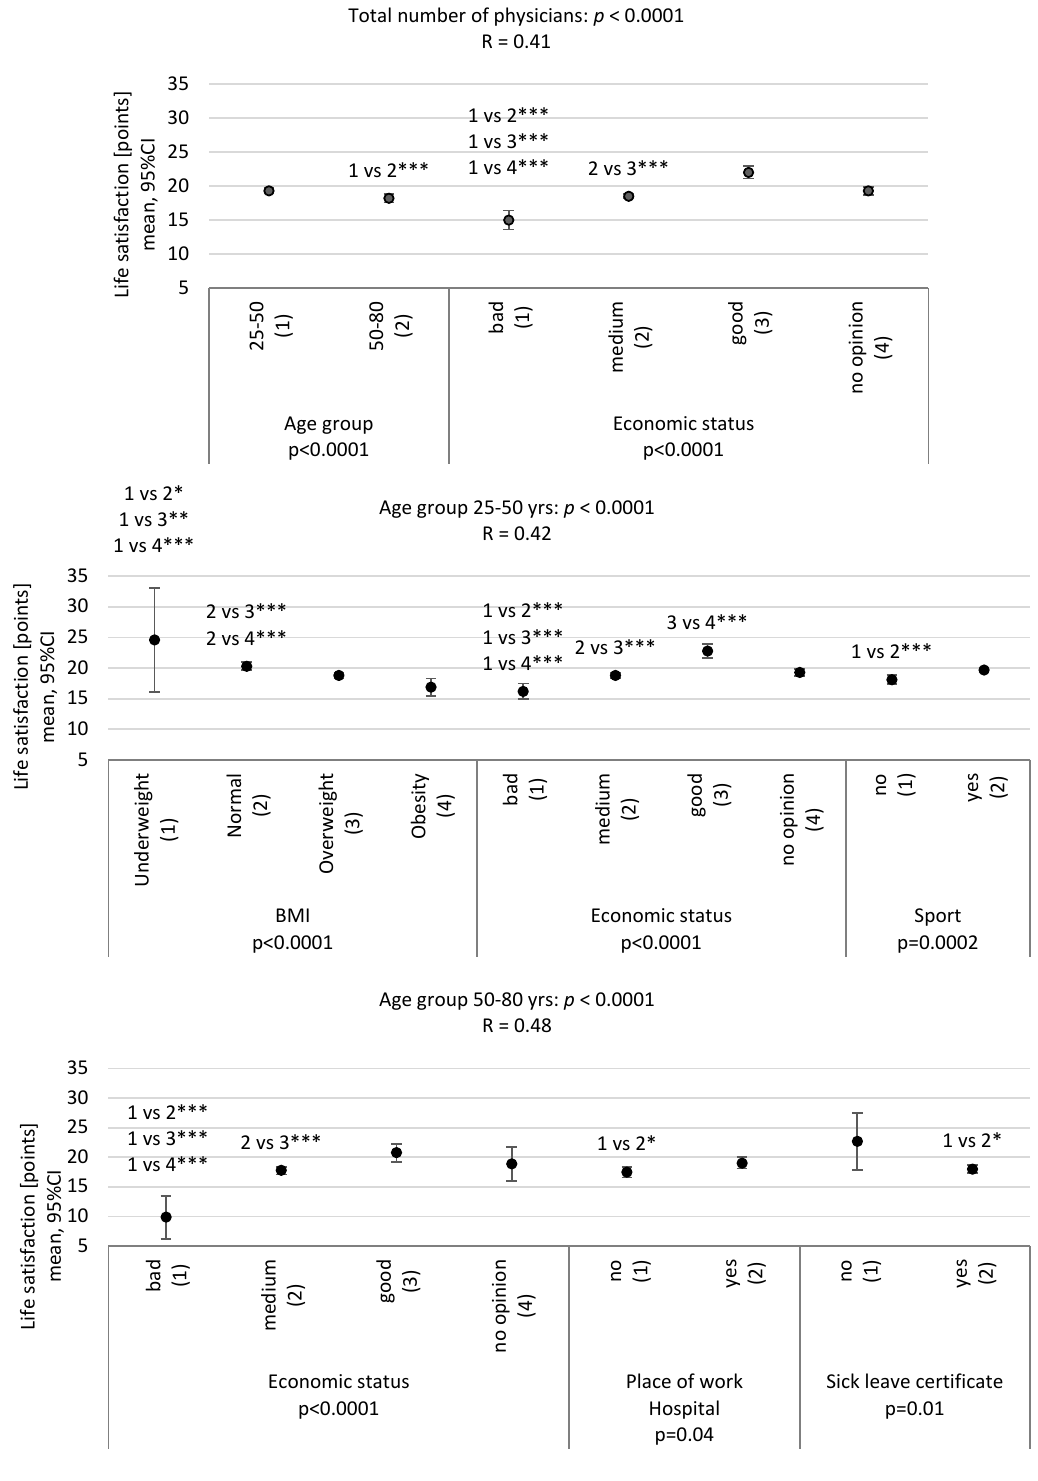
Figure 2. Analysis of variance model for the dependent variable (life satisfaction) for the study group (N = 701) and in accordance with the age group (25–50 yrs; 50–80 yrs). The result of the analysis of variance as a box-and-whisker plot for X, 95% CI—the mean and 95% Confidence Interval for the mean; p -value—the result of the multivariate ANOVA for quantitative characteristics with univariate significance tests; results of multiple comparisons: * p < 0.05; ** p < 0.01; *** p < 0.001